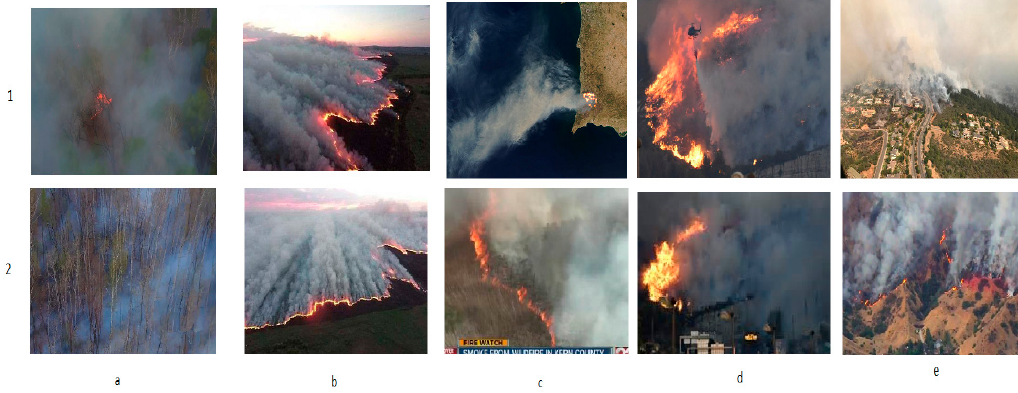
Figure 11. Examples of Fire_Net correctly-classified fire images from news reports. ( a ) Bilahe Forest fire, 2017; ( b ) Mongolia Forest fire, 2017; ( c ) South California wildfire and kern county wildfire, 2016; ( d ) Var wildfire, 2017; ( e ) La tuna and Napa valley wildfire, 2017.